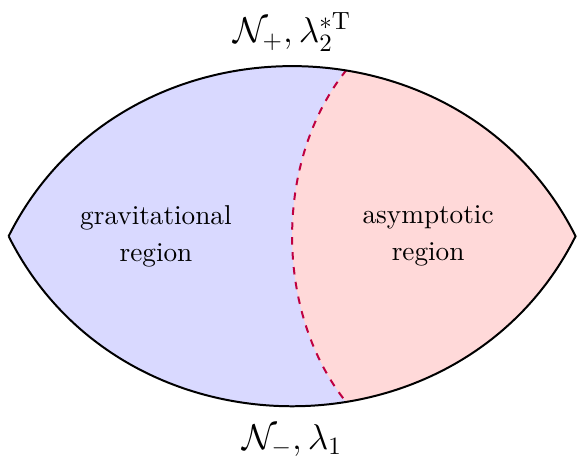
Figure 2. The manifold and fields for the partition function Z ( λ 2 , λ 1 ) must obey the boundary conditions λ 1 in the past N − , and the complex conjugate and time reversal of λ 2 in the future N +